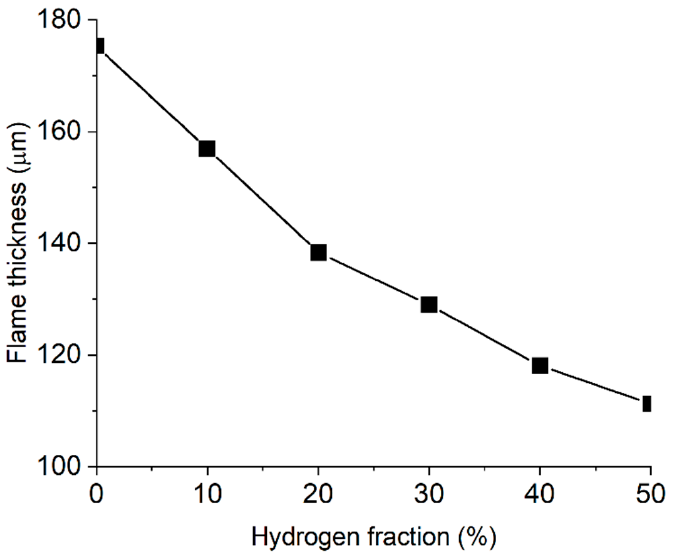
Figure 30. The curve of dependence of flame thickness on the volume fraction of hydrogen in the mixture [30].